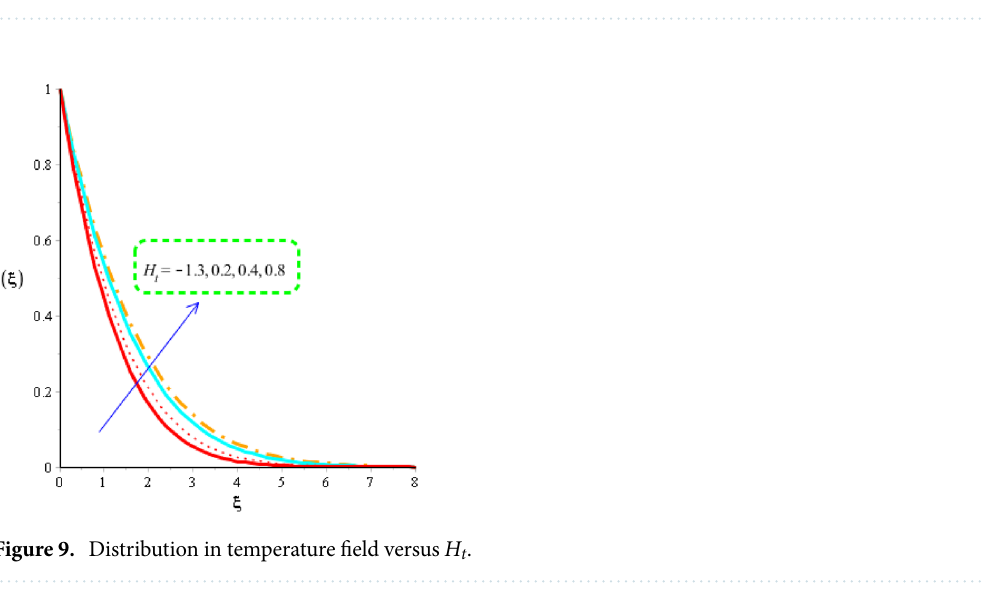
Figure 8. Distribution in temperature field versus M .